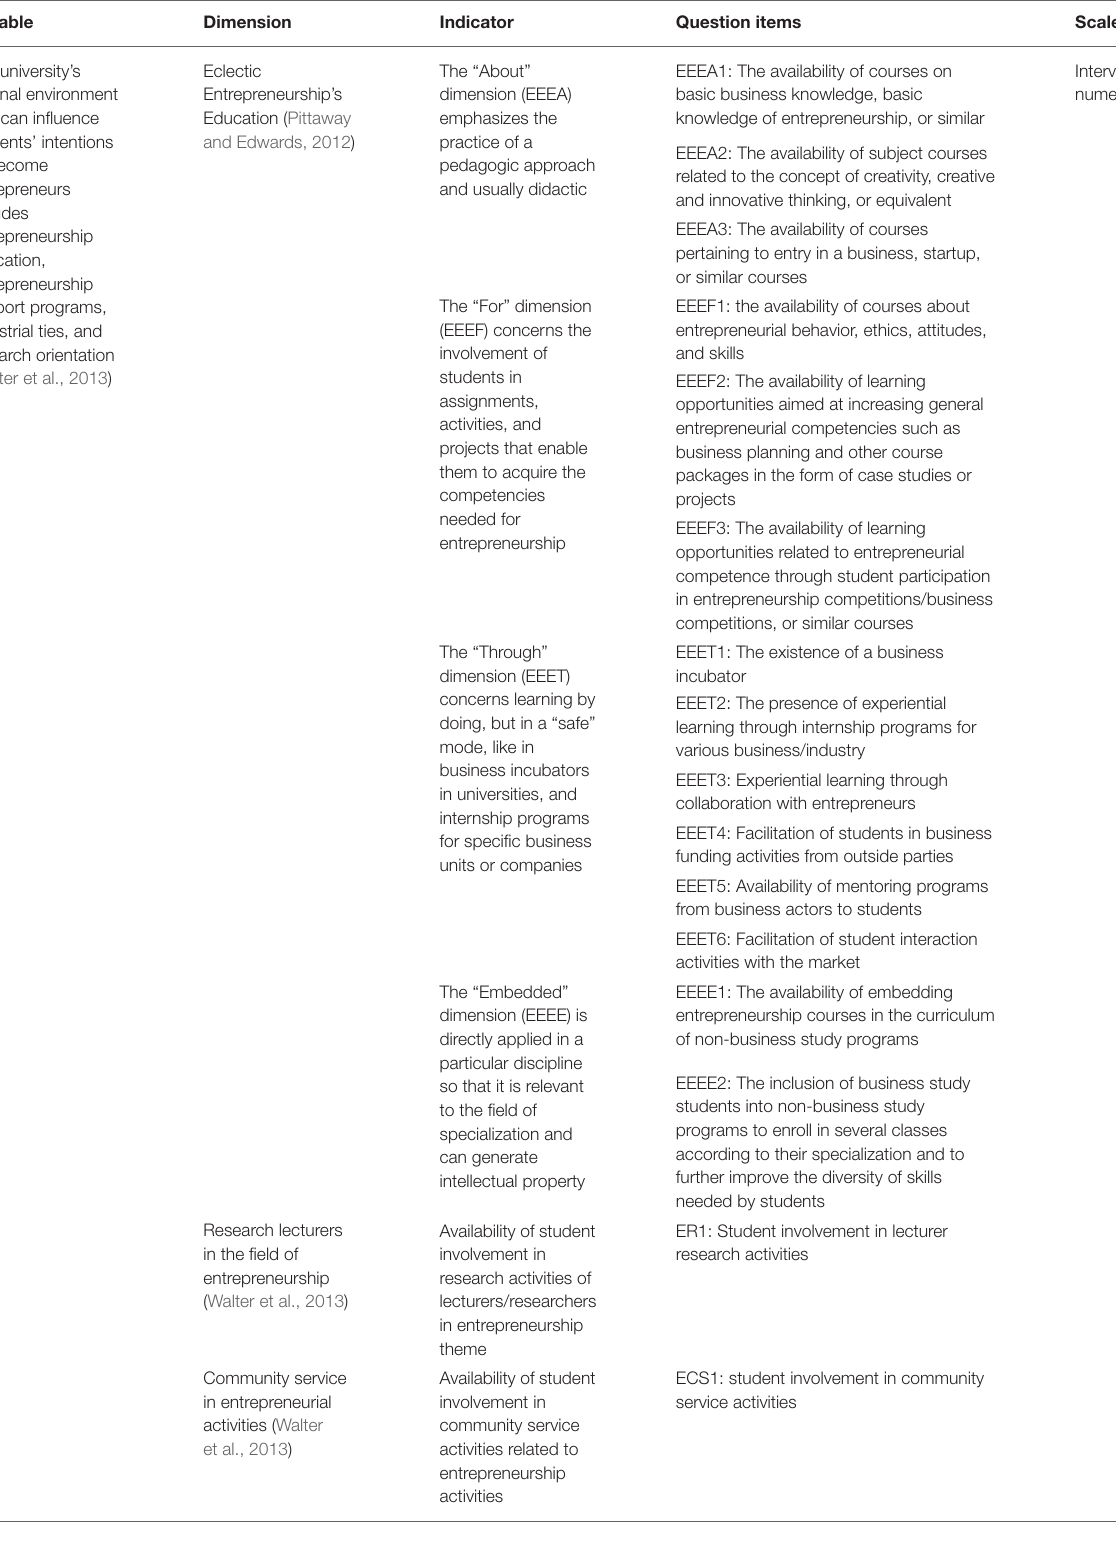
TABLE 1 | Variable operationalization. Variable